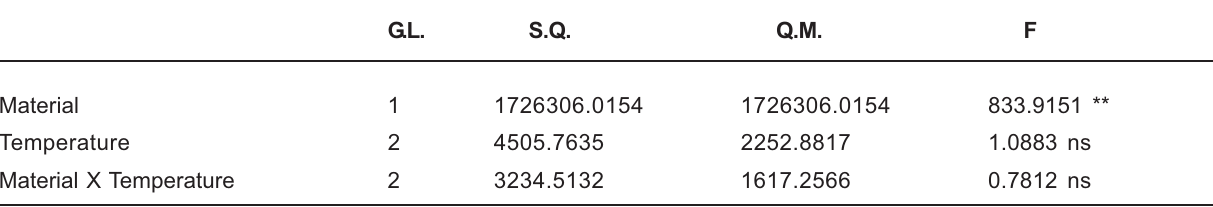
** - significantly different (p < 0.05)